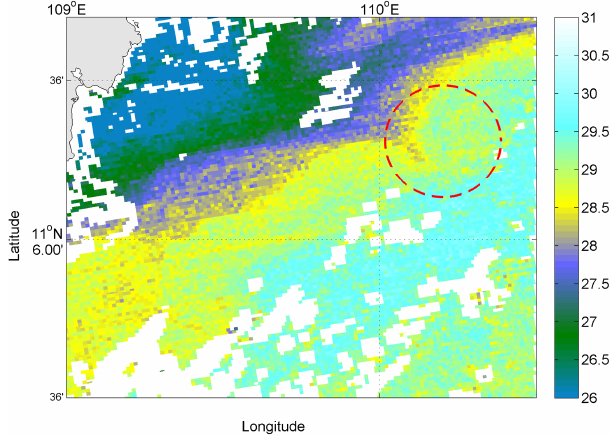
Figure 4. MODIS 1km sea surface temperature distribution (unit: ◦ ) on 13 July 2008.